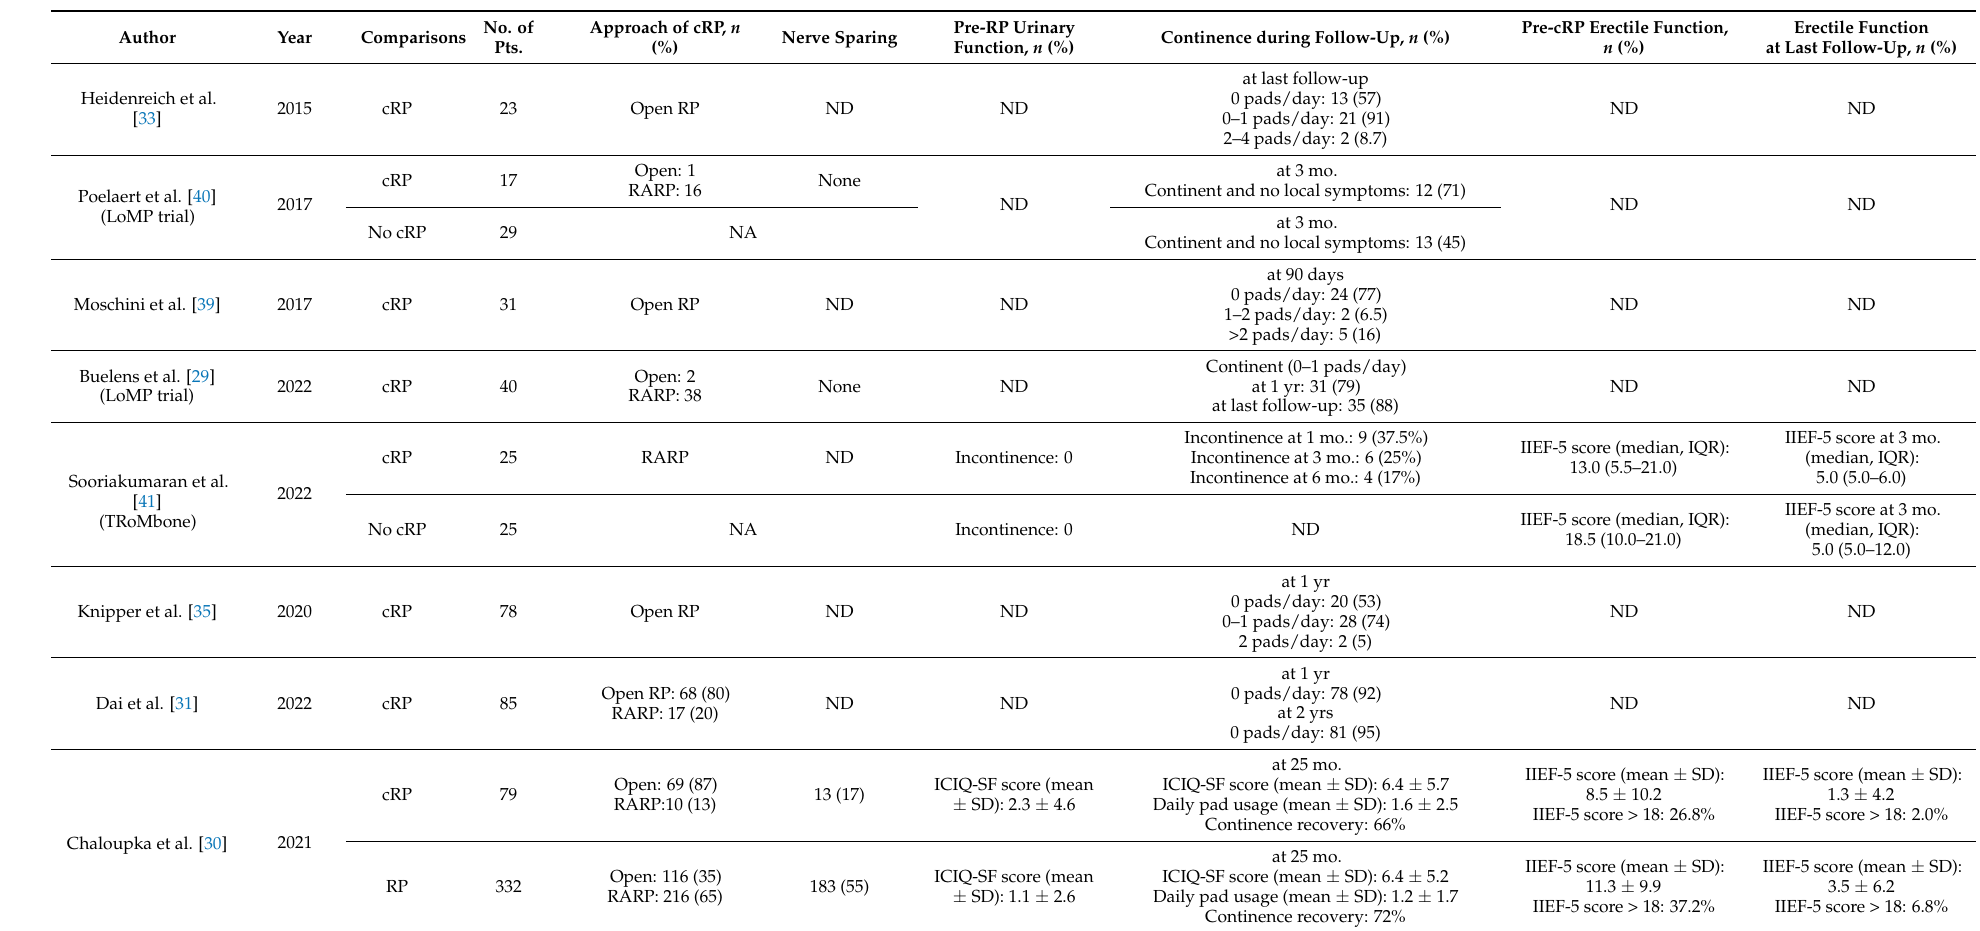
Table 4. Functional outcomes following